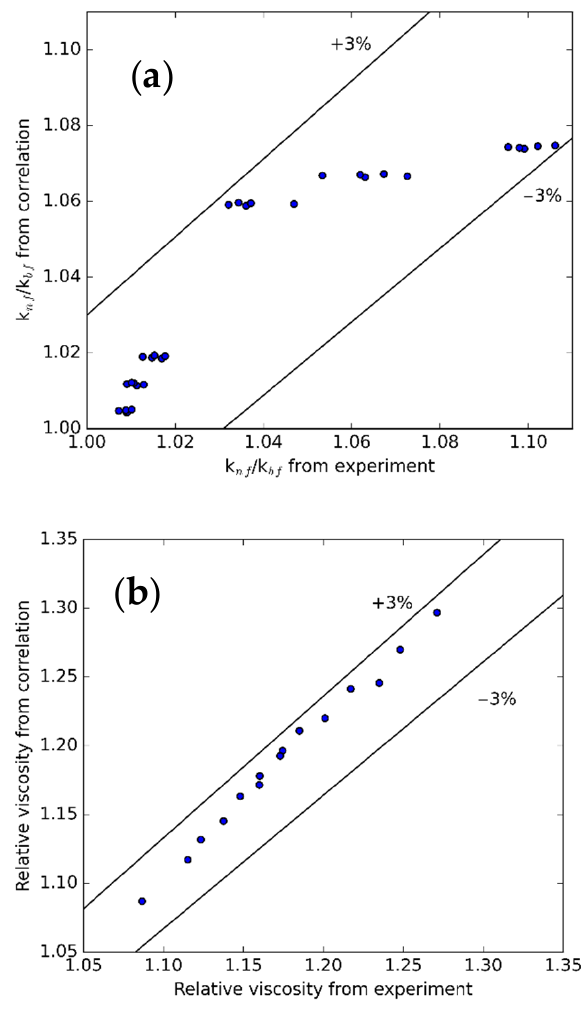
Figure 14. Comparison between ( a ) k and ( b ) µ obtained from experiment and proposed correla- tion.